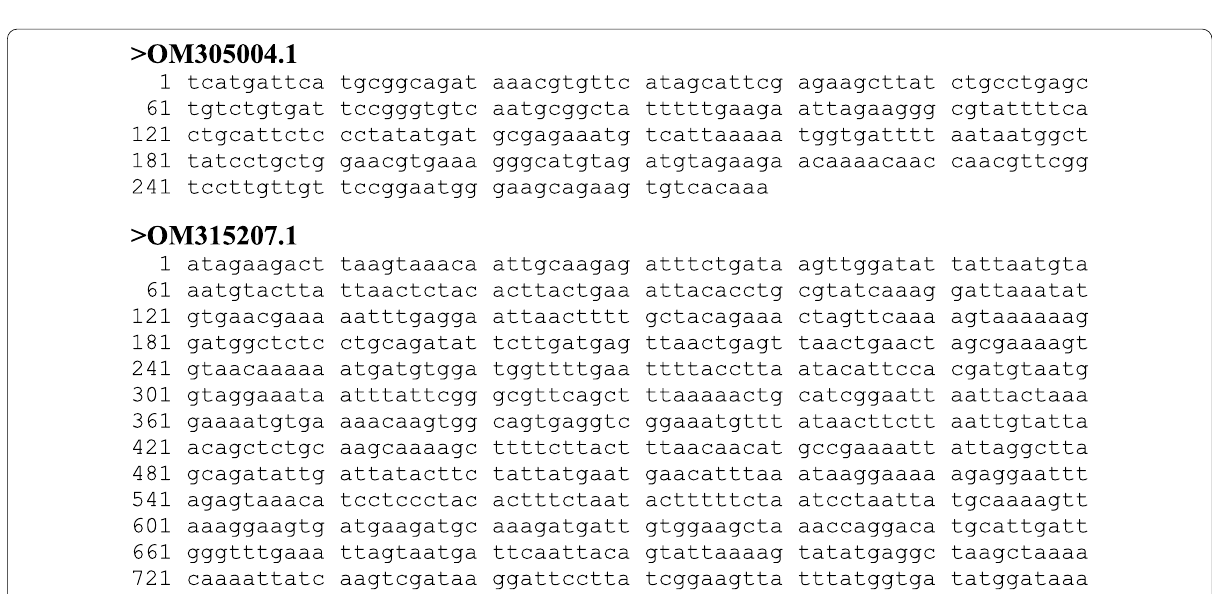
Fig. 4 Sequence results of partial cry1 and vip3A genes amplified from Bacillus thuringiensis isolate RM11